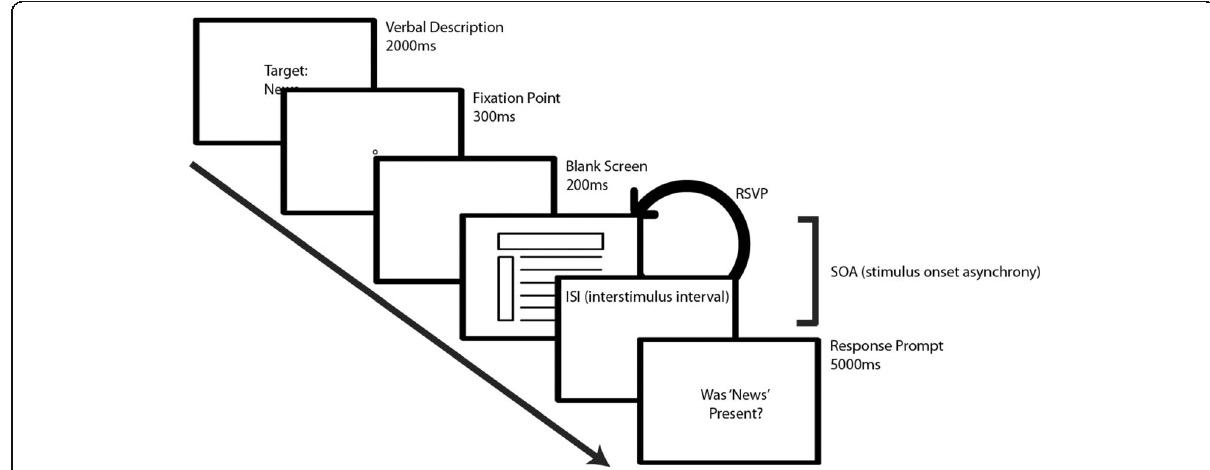
Fig. 3 RSVP trial schematic for Experiment